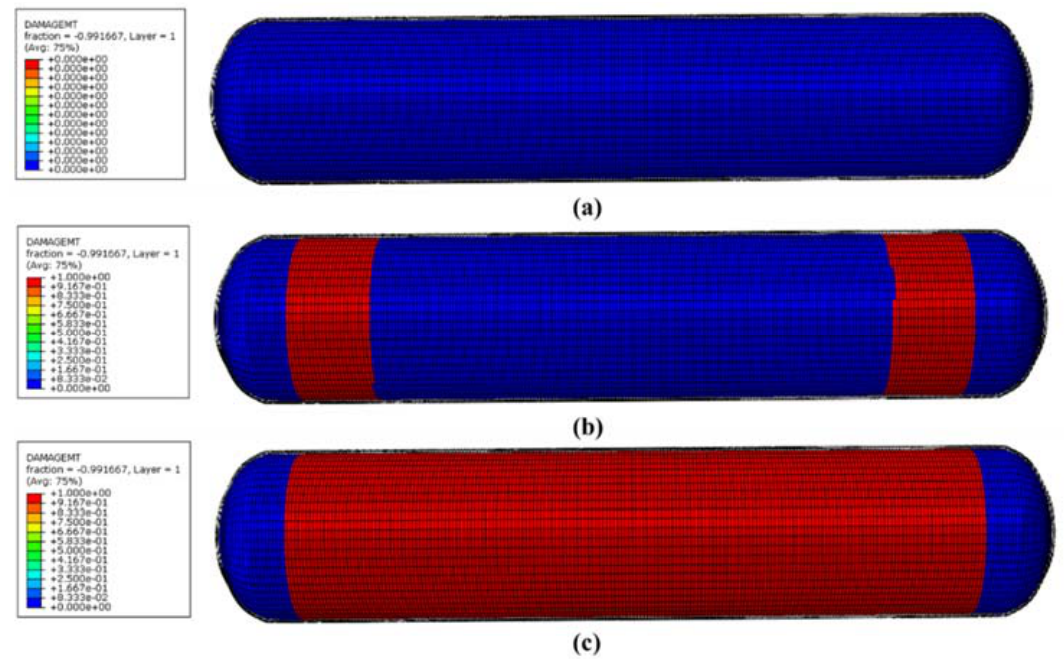
Figure 12. Fiber damage cloud image based on progressive failure: ( a ) fiber damage cloud image at 70 MPa; ( b ) fiber damage cloud image at 150 MPa; ( c ) fiber damage cloud image at 160 MPa.